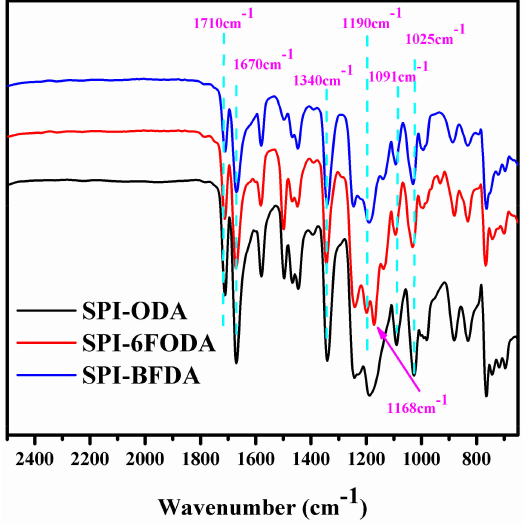
Figure 1. FT-IR spectra of three series of sulfonated polynaphthylimides